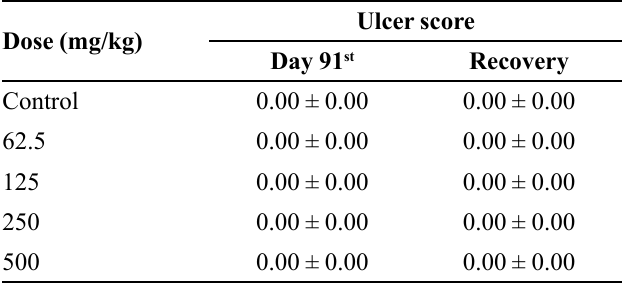
Values are presented as mean ± Standard error of mean (SEM), n=